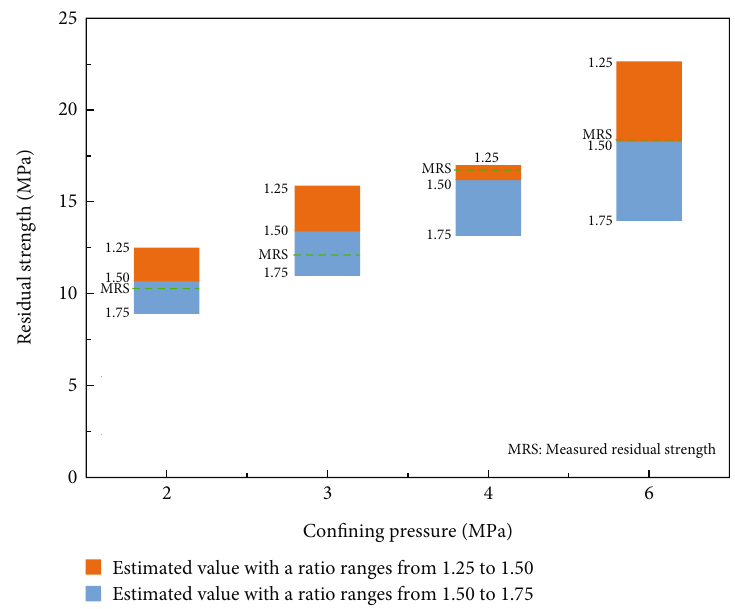
Figure 16: Simulation error analysis under di ff erent equivalent residual strain ratios.